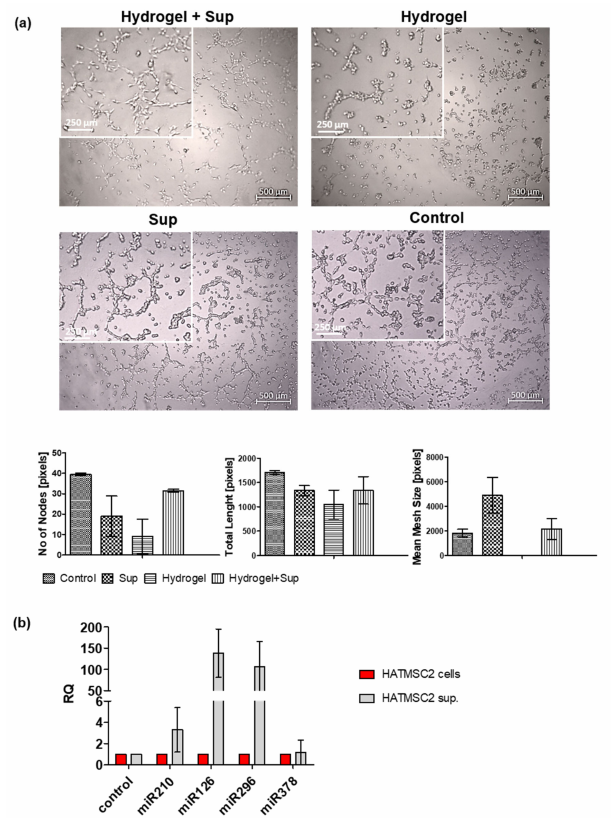
Figure 7. Pro-angiogenic activity of hydrogel-released HATMSC2 supernatant. ( a ) Representative images of in vitro angiogenesis of skin endothelial cells (HSkMEC.2) following 22h culture in the presence of supernatant-loaded hydrogel or supernatant treatment alone. The supernatant alone group (Sup) and Matrigel control (Control) are our positive controls. Graphs present quantification of angiogenesis by the number of nodes, total length of the tubes and mesh size. Inserts on the left top corners are 2.5 x magnifications of the original images. Data represent as mean ± SD, n = 2; ( b ) Relative expression of proangiogenic miRNAs, miR-210, miR-126, miR-296, and miR-378 in HATMSC2 supernatant. The expression of miRs was determined in a real-time RT-PCR experiment and measured relative to the control (HATMSC2 cells). Data were presented as mean ± SD values, n =